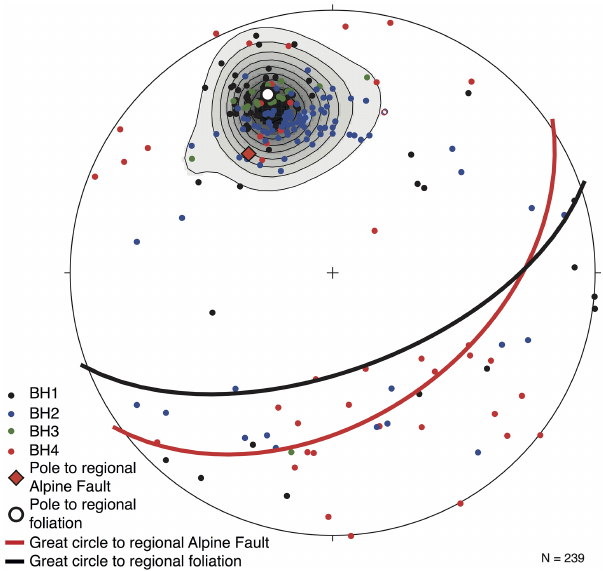
Figure 11. Equal area lower hemisphere projection of fracture ori- entations recognised in CT scans of AHP drill core separated by a borehole. Contours are plotted with weighted poles (see Fig.